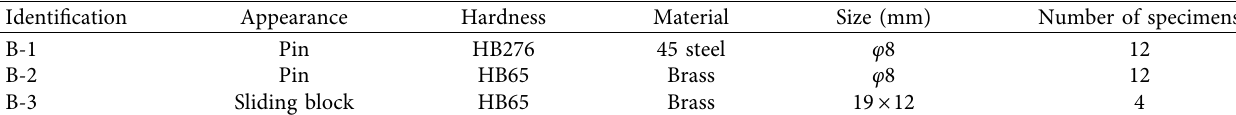
Table 4: Properties and parameters of metal